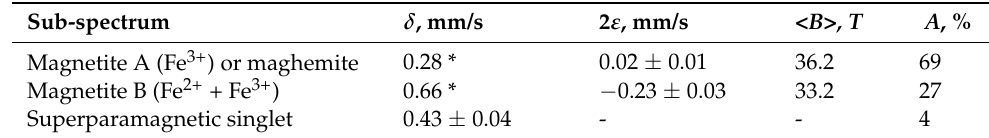
Figure 4. Mössbauer spectrum ( A ) of maghemite/magnetite nanoparticles at 21 ◦ C temperature and two hyperfine field distributions P( B ) ( B ) applied for fitting. Dashed gray line ( A ) given for comparison indicates fitting using one hyperfine field distribution. Table 1. Parameters of fitting to Mössbauer spectrum: isomer shift δ , quadrupole shift 2 ε , average hyperfine field <B> of distribution and relative area A attributed to magnetite §